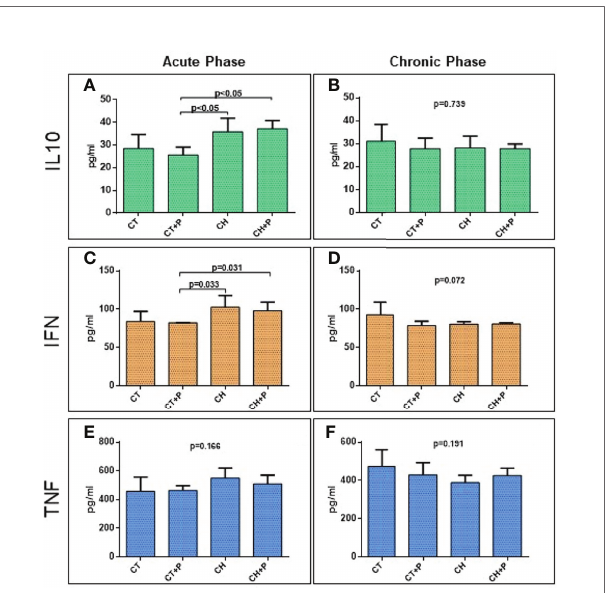
FIGURE 4 | Gene expression of oxidative stress genes. (A) NOX1 gene expression in the acute phase (n=49); (B) NOX1 gene expression in the chronic phase (n=38). (C) MnSOD gene expression in the acute phase (n=49); (D) MnSOD gene expression in the chronic phase (n=38), (E) iNOS gene expression in the acute phase (n=49); (F) iNOS in the chronic phase (n=38). CT - control group, CT+P – control group exposed to pollution, CH – chagasic group, CH+P – chagasic group exposed to pollution.